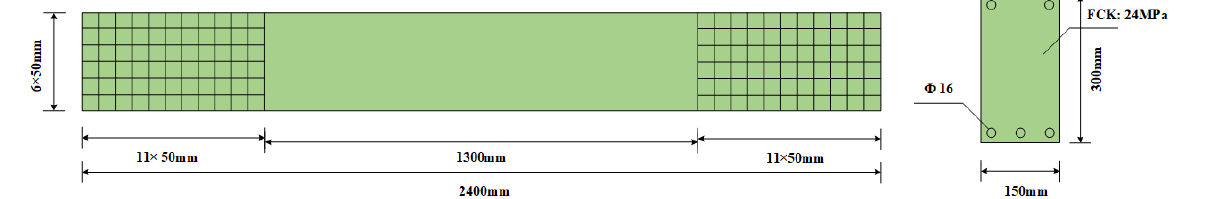
Figure 1. Schematic illustration of longitudinal section and cross section of the RC beam.